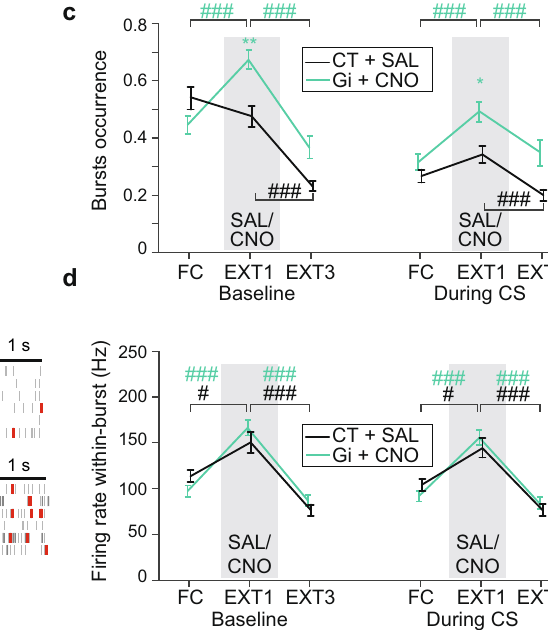
Fig. 5 | Chemogenetic inhibition of FN-MD input during EXT1 increases burst occurrence in the MD. a Example of burst detection in a spiketrain from a MD neuron, bursts are represented in red, and their associated p -values are reported. Onesample t -testonISIofburtscomparedtothelocaldistributionofISI.* p